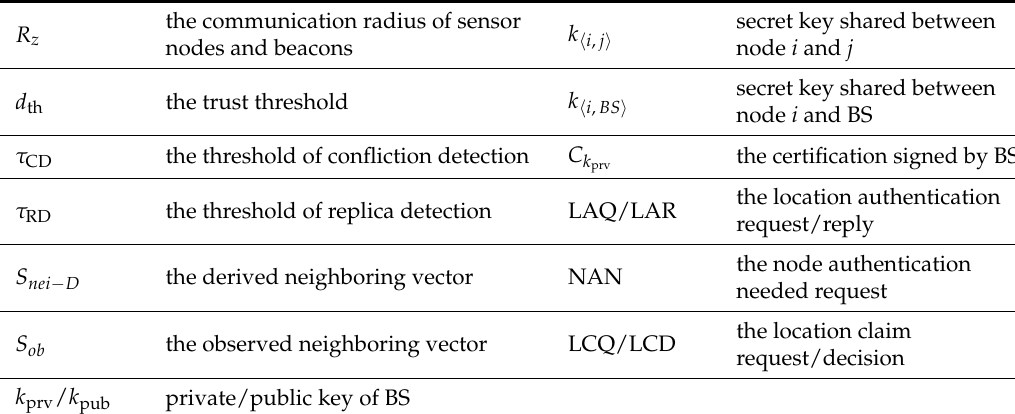
Table 1. Frequently-used notations in this